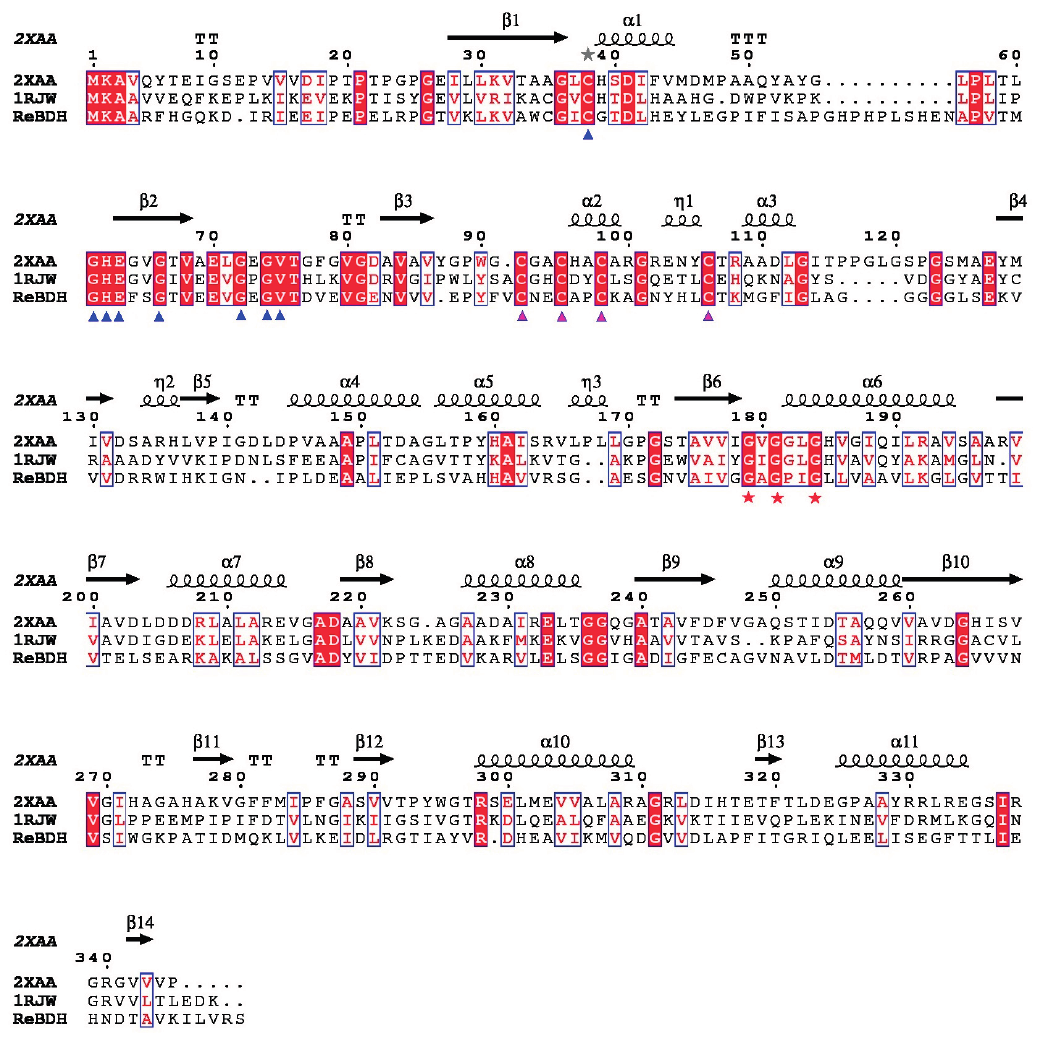
Figure 2. Structure-related sequence alignment between ReBDH and two homologous proteins with known three-dimensional structure. PDB codes for the sequences are as follows: 2XAA, alcohol dehydrogenase from Rhodococcus ruber DSM 44541 [28]; 1RJW, alcohol dehydrogenase from Bacillus stearothermophilus [29]. Shown above the alignments are elements of the secondary structure of 2XAA. The numbering shown is from 2XAA. Blue triangles, putative catalytic residues; red stars, putative coenzyme binding motif; pink triangles, the residues for the coordination of structural zinc. Strictly conserved residues are highlighted with red